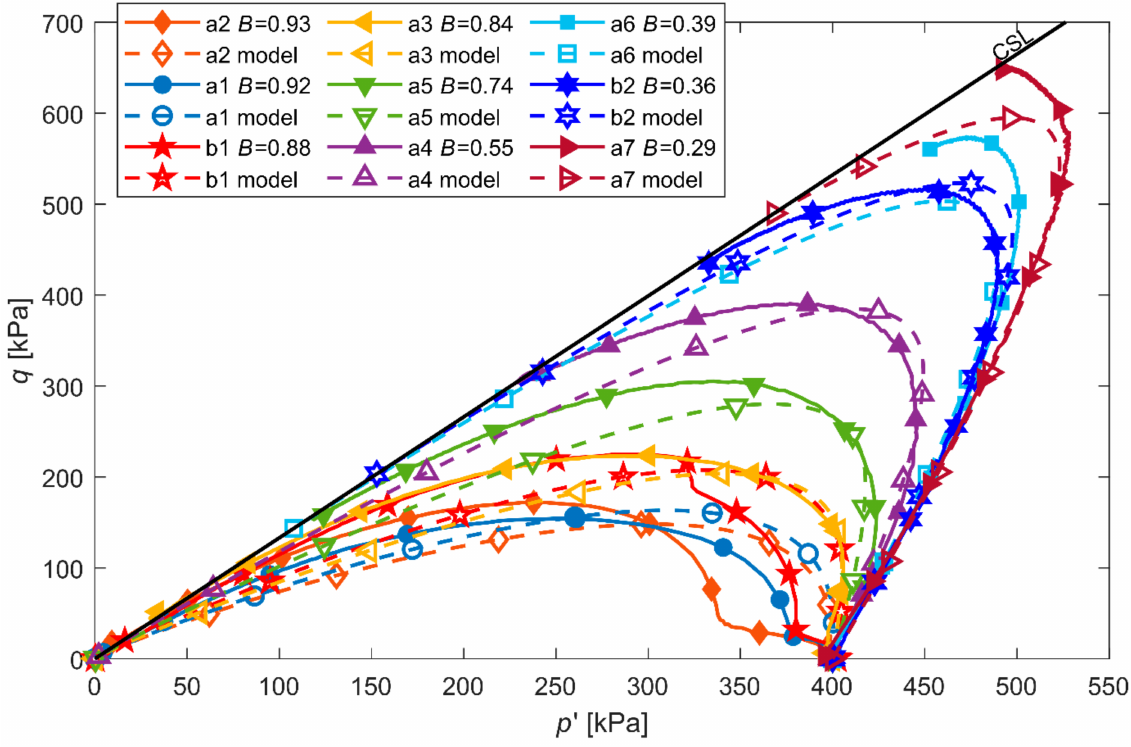
Figure 22. Theoretical predictions of triaxial compression tests of partially saturated OZM50 tailings vs. experimental